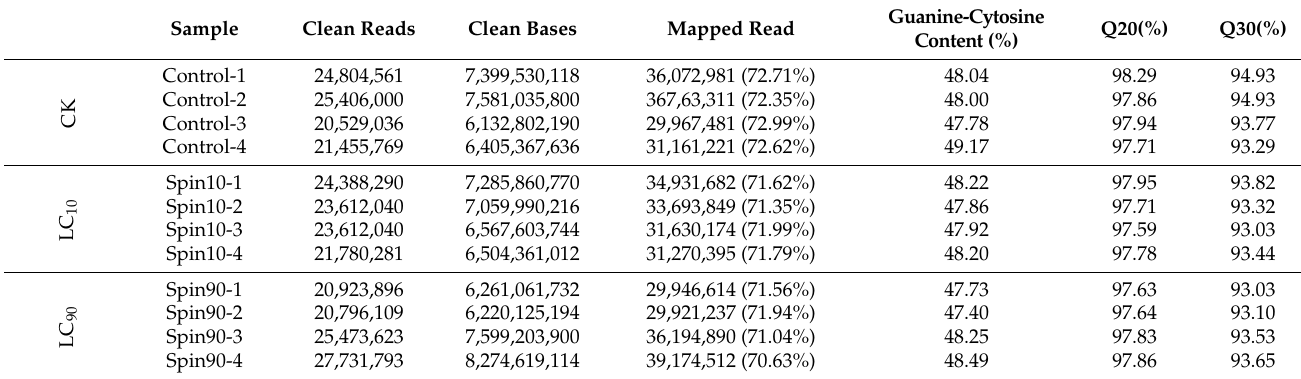
Table 1. Summary of transcriptome sequencing data.